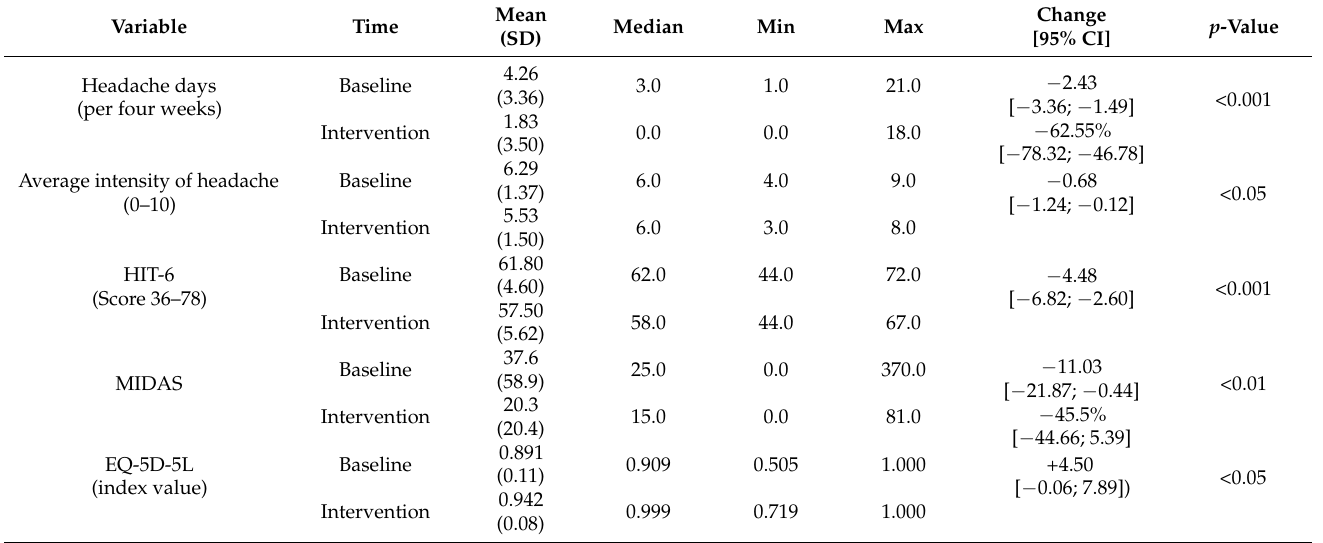
Table 1. Comparison of disease severity between the four-week baseline phase and the last four- weeks of the intervention phase of the first study ( n = 49). The disease severity was defined by the number of headache days, the average intensity of headache, Headache Impact Test-6 items (HIT-6), Migraine Disability Score (MIDAS) and quality of life